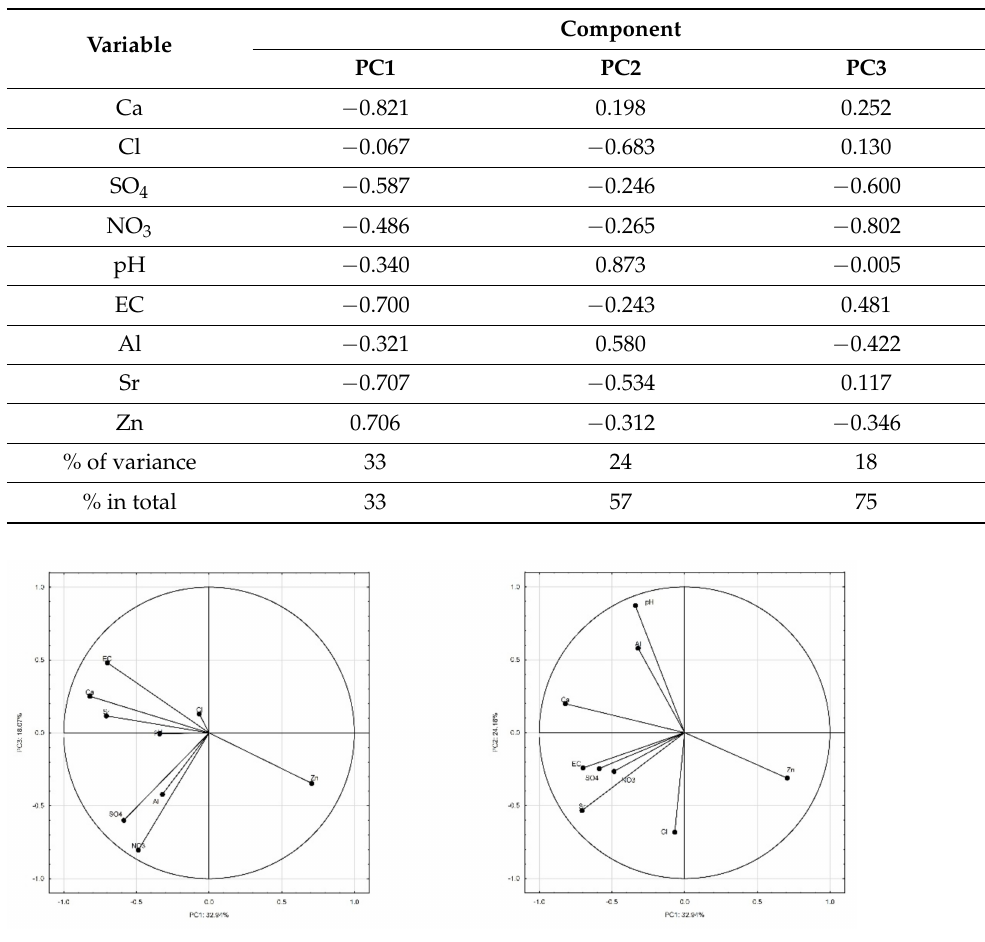
Table 3. PCA analysis of the studied physico-chemical parameters (N-13).